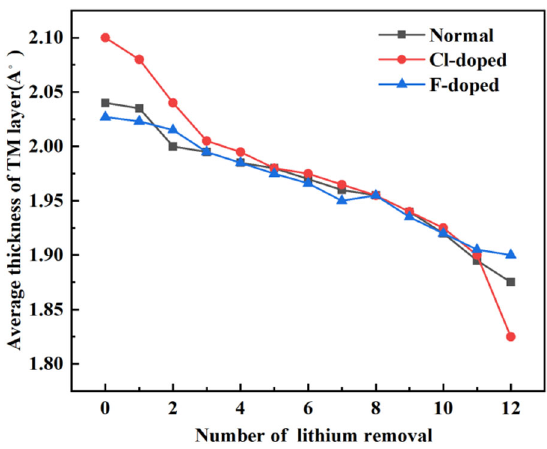
Figure 7. Average thickness change in TM layer in the process of lithium removal.